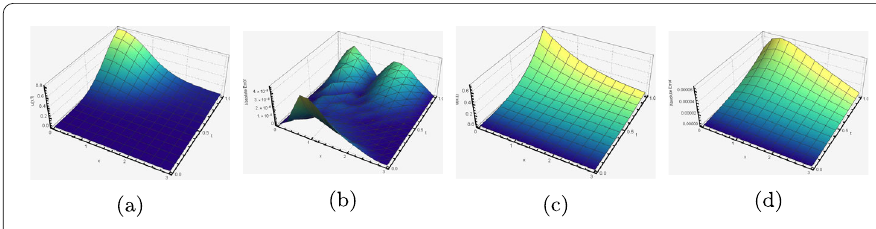
Figure 6 ( a ) and ( b ) represent approximate solution and absolute error distribution, respectively, using SJSCM. ( c ) and ( d ) represent approximate solution and absolute error distribution, respectively, using the